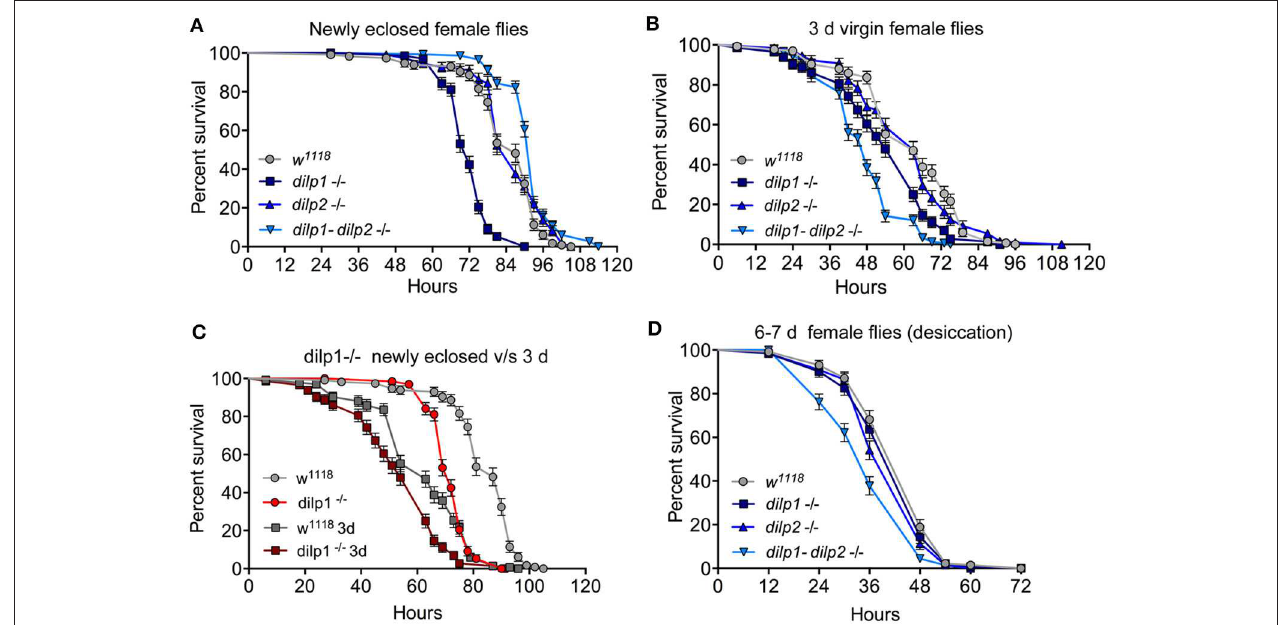
FIGURE 6 | Effects of mutated dilp genes on adult responses to starvation and desiccation change in early adult life. (A) In newly eclosed female flies, dilp1 mutant flies display reduced survival during starvation ( p < 0.001) compared to the other mutants and control. The double mutant is significantly more resistant ( p < 0.001). n = 109–147 flies for each genotype from three independent replicates. (B) In 3-day-old virgin female flies, dilp1-dilp2 double mutants are the least starvation resistant ( p < 0.001) followed by the dilp1 mutants; n = 129–148 flies for each genotype from three independent replicates. (C) Comparison between newly eclosed and 3-day-old flies exposed to starvation. Both mutants and controls survive longer as recently eclosed flies and mutants perform worse than controls at each time point ( p < 0.001). n = 114–144 flies from three independent replicates. (D) When exposed to desiccation, 6- to 7-day-old female double mutants are less resistant than the other genotypes ( p < 0.001), n = 132–135 flies from three independent replicates. Data are presented in survival curves and the error bars show S.E.M., as assessed by log-rank (Mantel–Cox)